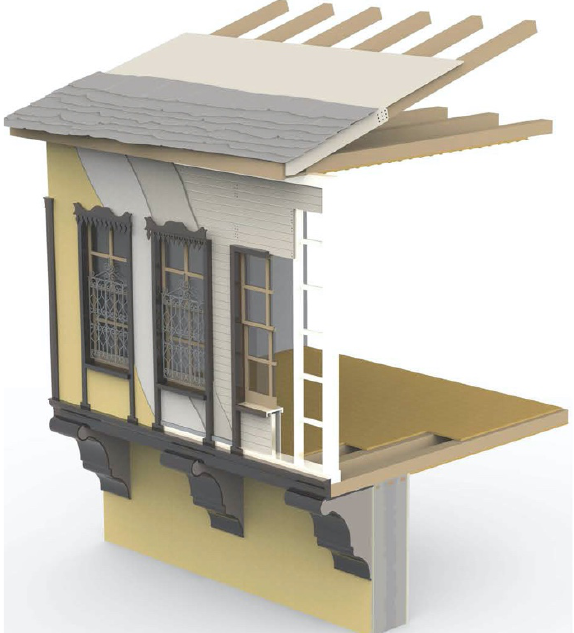
Figure 9. Detail of the çatma technique in Fico house (© Koli